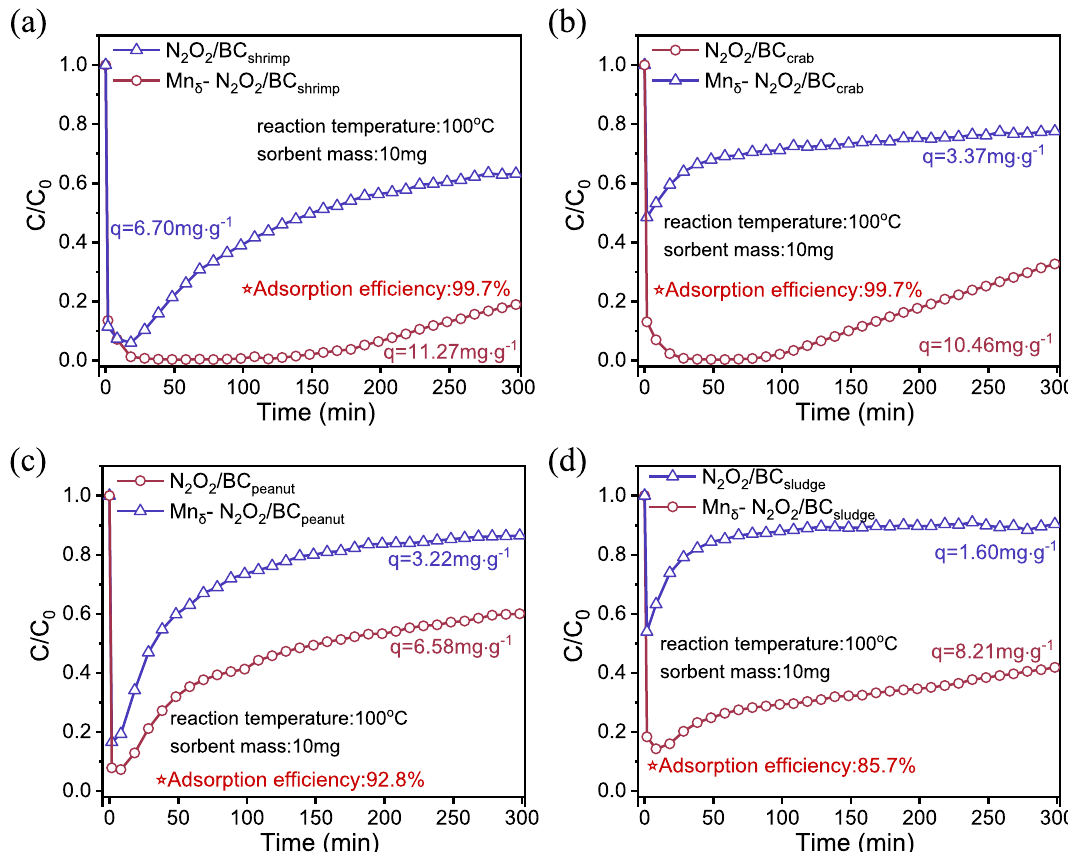
Fig. 3 Comparison of Hg 0 adsorption curve between N 2 O 2 /BC and Mn δ -N 2 O 2 /BC. ( a ) Shrimp, ( b ) Crab, ( c ) Peanut, ( d )